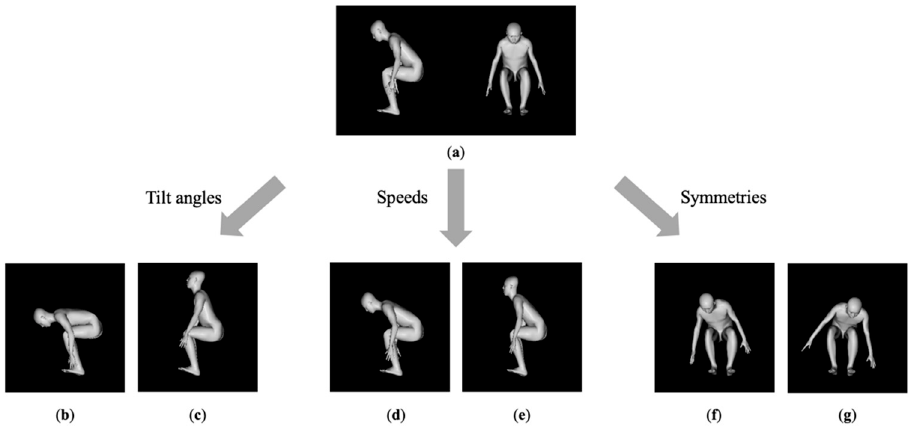
Figure 3. Experimental conditions analyzed in this study. ( a ) Normal; ( b ) Increase in the trunk anterior tilt; ( c ) Decrease in the trunk anterior tilt; ( d ) Slow speed; ( e ) Fast speed; ( f ) Right-side weight shift; ( g ) Left-side weight shift.